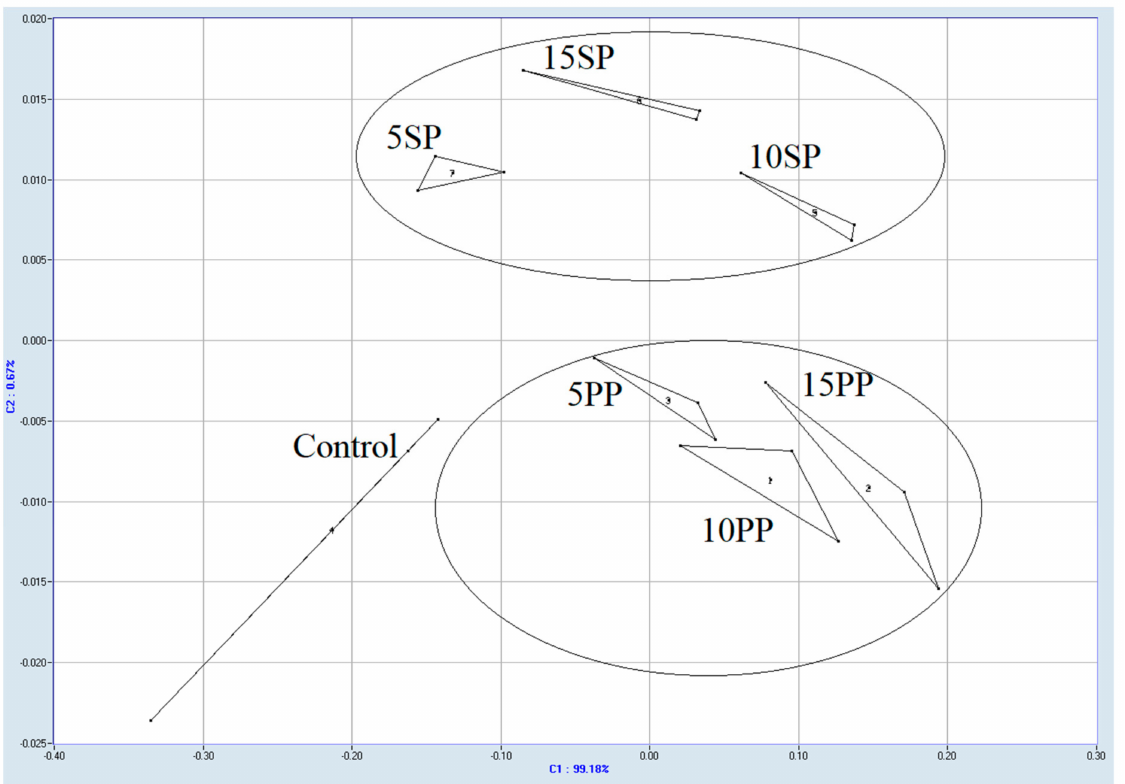
Figure 3. Principal component analysis (PCA) plot for the bread samples: control, pea (5PP, 10PP, and 15 PP), and soy (5SP, 10 SP, and 15SP)